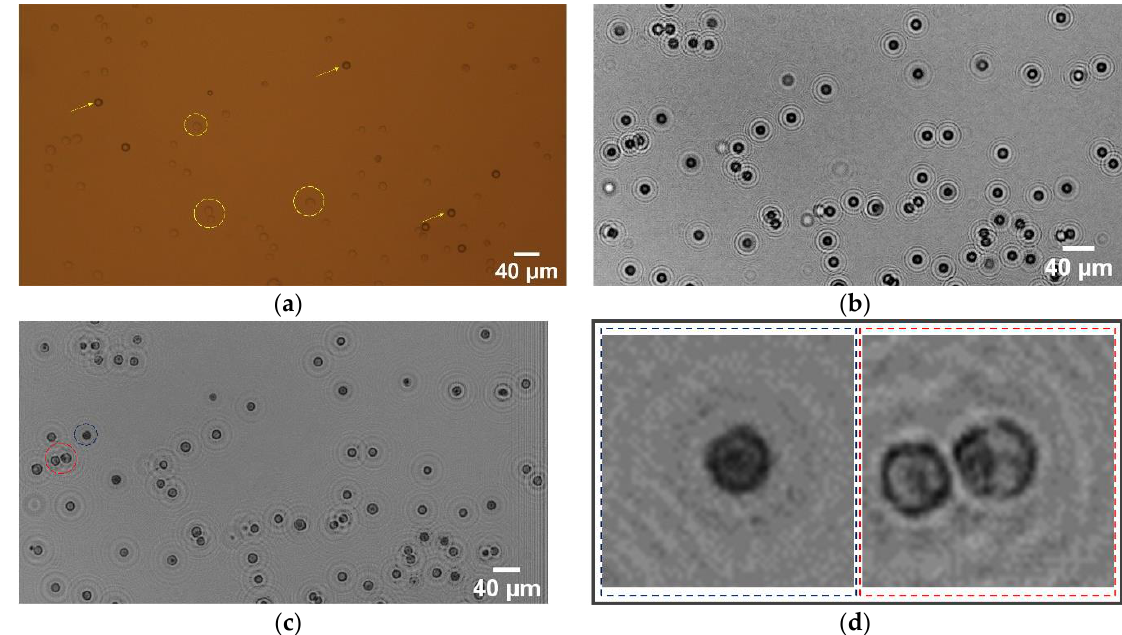
Figure 4. Results of the holographic imaging experiment process. ( a ) Microscope image, ( b ) raw holographic image, ( c ) iteratively recovered image, ( d ) insets of the iteratively recovered image.